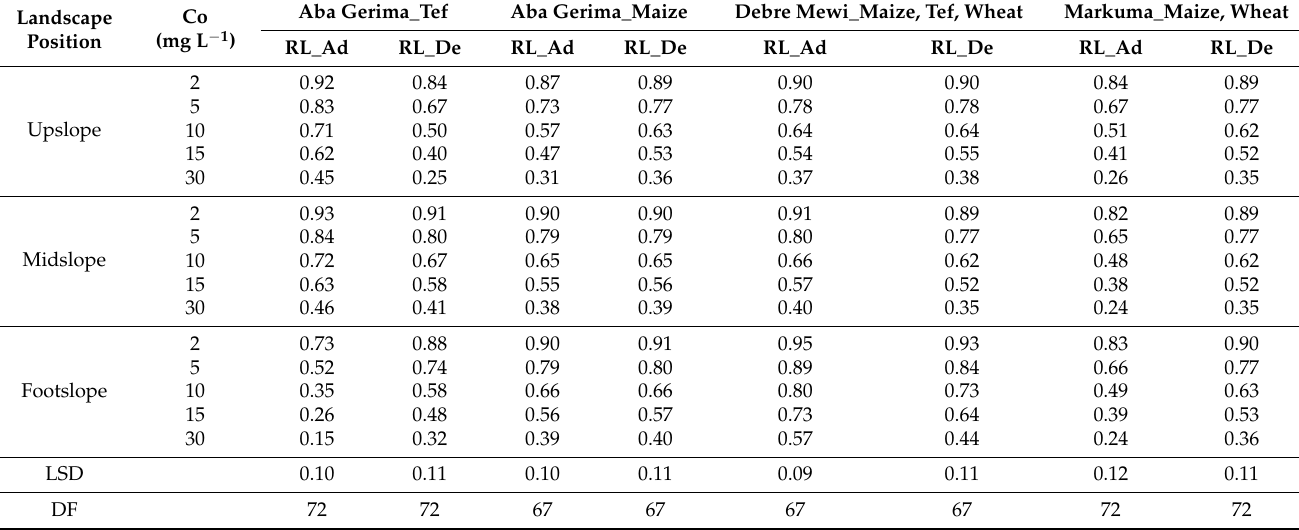
Table 3. Summary of the RL factor for adsorption and